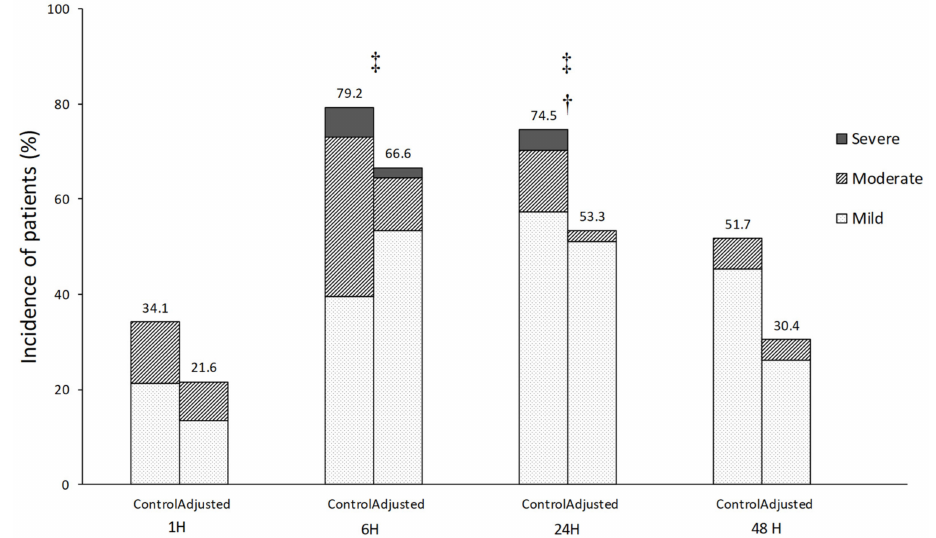
Figure 4. The incidence and severity of postoperative sore throat (POST). The incidence of POST was lower in the adjusted group than in the control group at 24 h postoperatively (53.3% vs. 74.5%, p = 0.035). The severity of POST was less severe in the adjusted group than in the control group at 6 h ( p = 0.034) and 24 h postoperatively ( p = 0.034). † p < 0.05, the incidence of POST; ‡ p < 0.05, the severity of